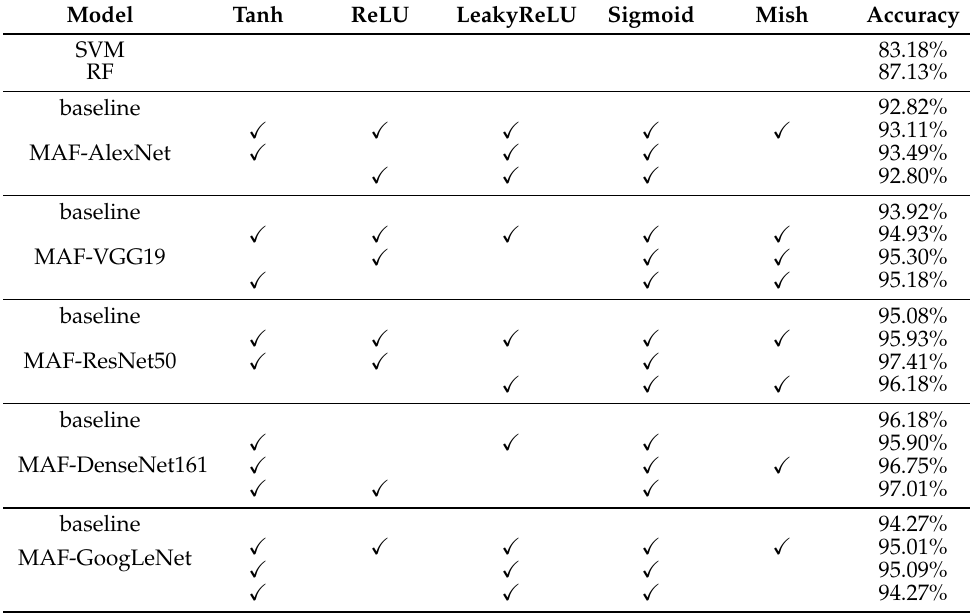
Table 3. Accuracy of different